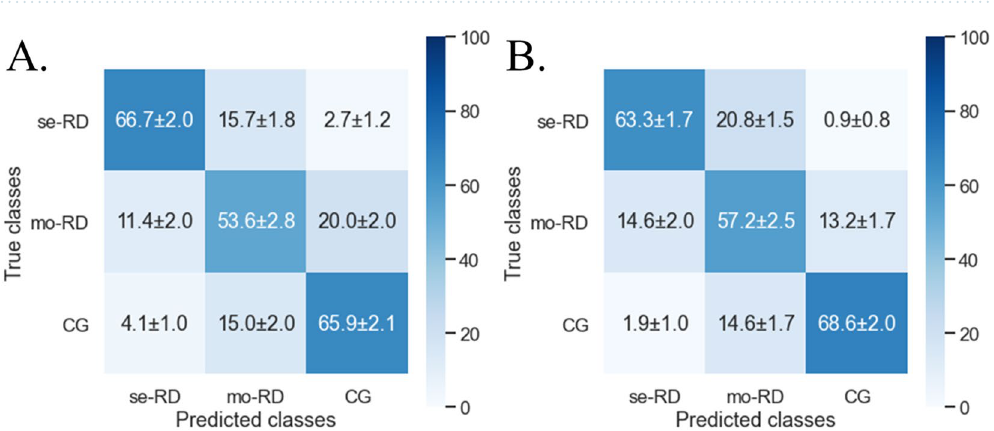
Figure 2. Confusion matrices show the status of representative classification models using T1-weighted water- only images with a random forest classifier ( A ) and all T1-weighted images using a support vector machine with rbf kernel classifier ( B ) in classifying the three groups of chronic kidney disease. Severe renal dysfunction group (se-RD, estimated glomerular filtration rate [eGFR] < 30 mL/min/1.73 m 2 ), moderate renal dysfunction group (mo-RD, 30 ≤ eGFR < 60 mL/min/1.73 m 2 ), and control group (CG, eGFR ≥ 60 mL/min/1.73 m 2 ). The data are expressed as means ± standard